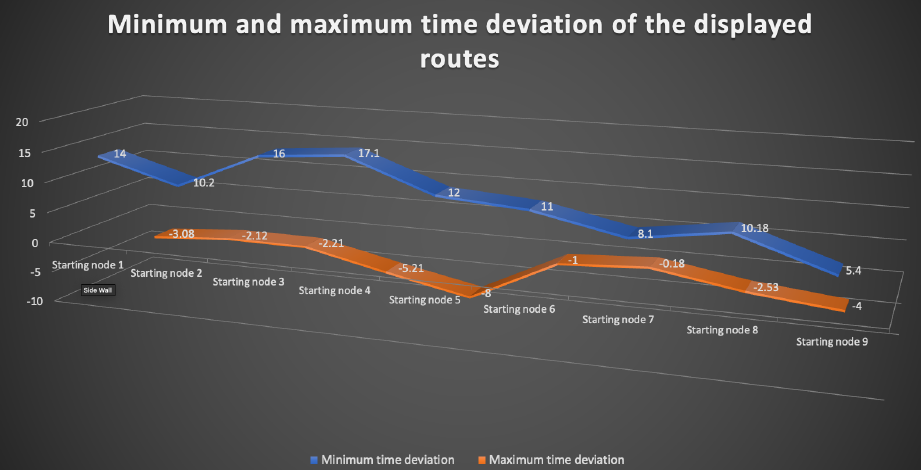
Figure 5. Minimum and maximum distance deviation of the displayed